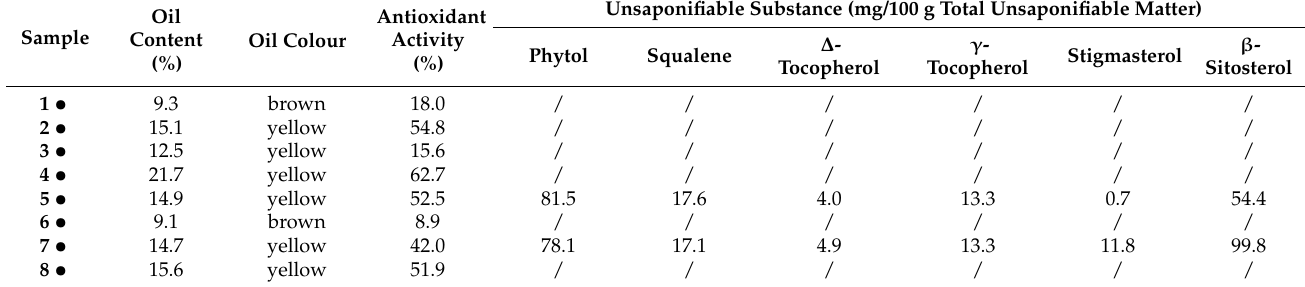
Table 1. Oil content, oil colour, antioxidant activity, and content and composition of unsaponifiable matter. Unsaponifiable matter denoted with “/” was not determined due to limited amounts of oil samples. Unsaponifiable matter denoted with “<LOQ” was below limit of quantification. Tilia cordata samples are marked with circles and Tilia platyphyllos samples are marked with